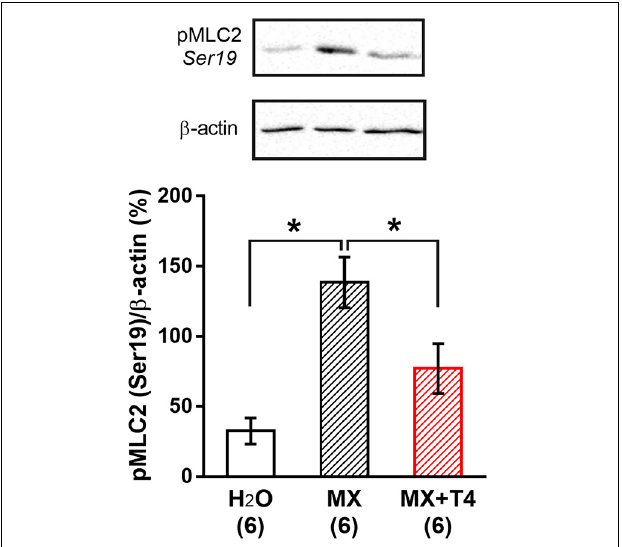
FIGURE 5 | T4 weakens the methoxamine-induced increase in phospho-MLC2 (Ser19) content in sural arteries. The representative membrane parts are shown in the top. Data were normalized to β -actin level in the same sample and then the average value of two reference samples was taken as 100%. Number in parentheses represents the number of animals. * p < 0.05 (one-way ANOVA with Dunnett post hoc test).